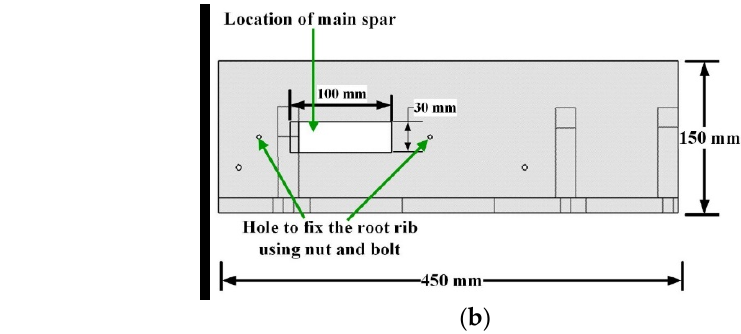
Figure 18. Fuselage frame of the ASAPP wing: ( a ) Front view. ( b ) Side view.